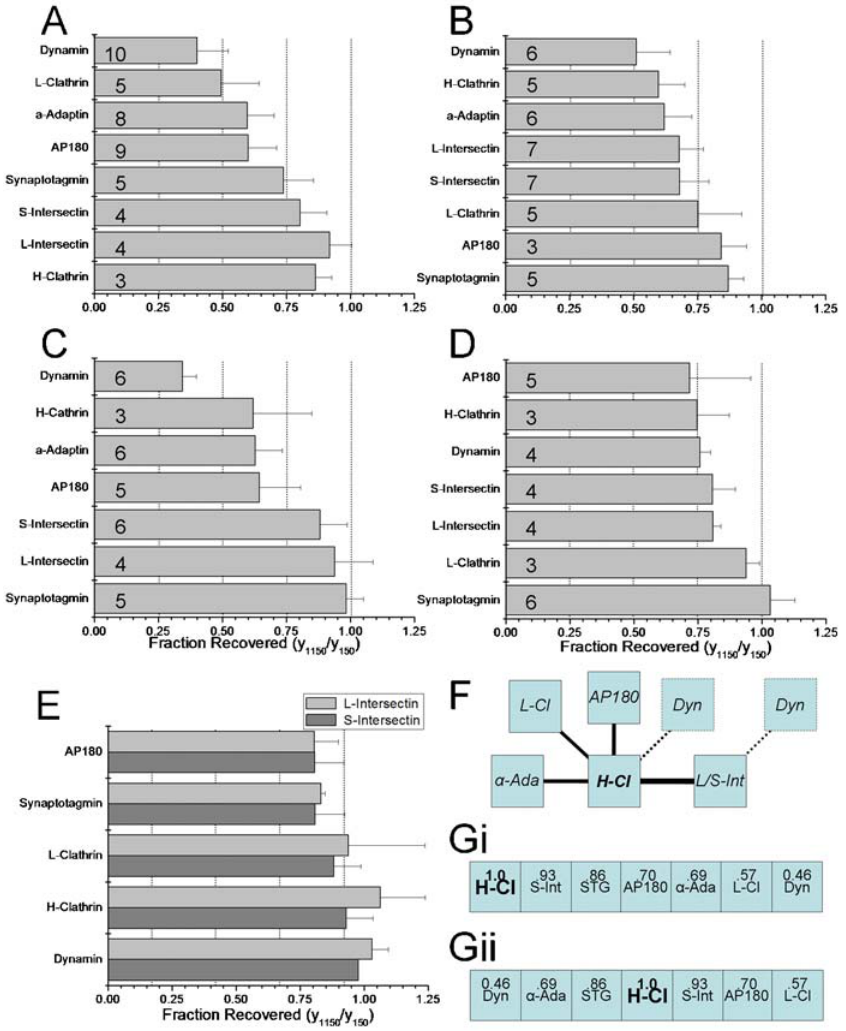
Figure 3. FR analysis of SAE. Analysis frequency histograms. Each plot shows the fraction of a variety of co-IP-protein recovered at 1150:150 mM salt after immunoprecipitation with antibodies to ( A ) H-clathrin, ( B ) AP180, ( C ) L-clathrin, and ( D ) STG (the IP-proteins). Each bar is the mean 6 SE of the indicated number of separate IP experiments as in Fig.1C . The vertical dotted lines indicate the 0.25, 0.50, 0.75 and 1.00 recovery fractions. E. Plot of mean 6 SE FR values for IP of S- or L-intersectin compiled from co-IP values for the indicated IP-proteins ( y axis ; see text ). F,G. Protein complex model relative to the IP-protein . Working models of the protein complex depicted by the FR set for a single IP-protein using H-clathrin as an example. In F the co-IP proteins are displayed with linking bars with widths proportional to their FR value (there is no significance to the distance between the proteins in this diagram). Dynamin is depicted as either linked directly to H-clathrin or, because of its low FR value, linked via intersectin ( see text ). In G the complex is depicted as a linear sequence of co-IP proteins in order of their normalized FR values (number in box) starting from the IP protein, H- clathrin, on one end ( i ) or at the centre ( ii ) of the complex. FR values for S- and L-intersectin were very similar as if they can substitute for each other in this complex. Figure abbreviations: S-Int, short-variant intersectin; STG, synaptotagmin; a -Ada, a -adaptin; L-Cl, L-clathrin; Dyn,